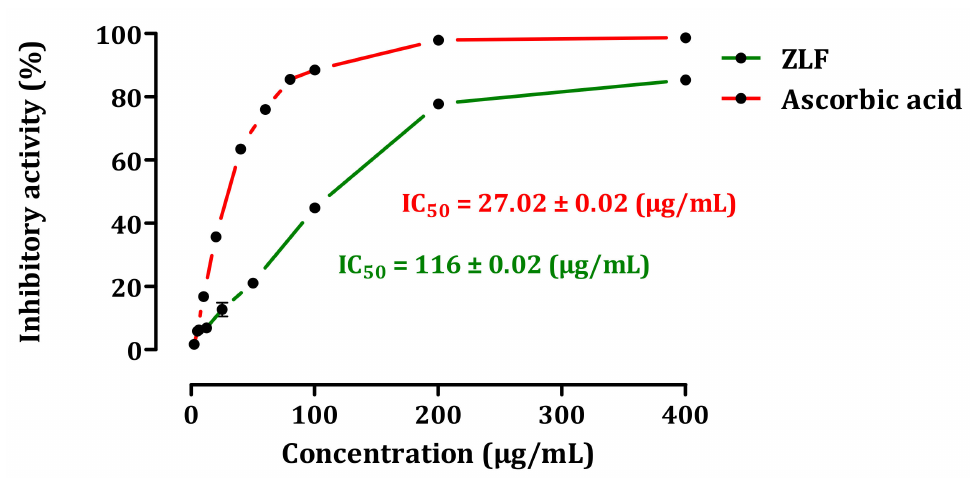
Figure 2. DPPH Free radical scavenging activity of ZLF extract and ascorbic acid.